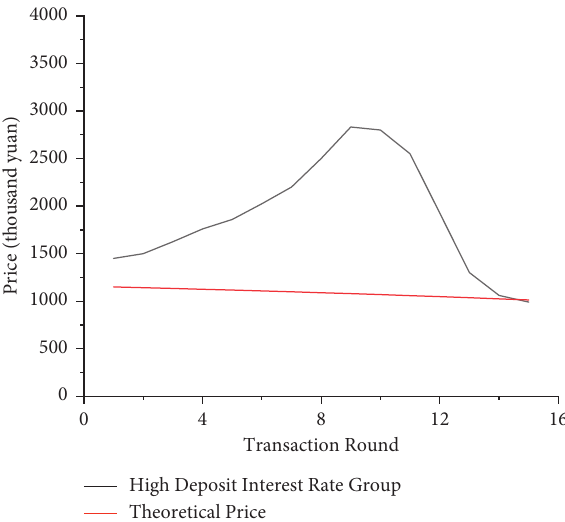
Figure 2: The average trading price and theoretical price of the high deposit interest rate group of each transaction